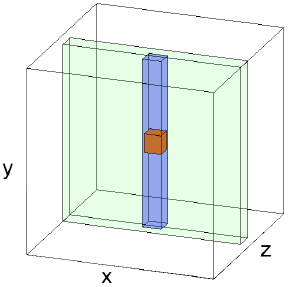
FIG. 1. Illustration of high dimensional slices in 3D space. A slice of the cube can be made along one dimension (e.g., ˜ z ¼ 0 , the green volume), two dimensions ( ˜ z; ˜ x ¼ 0 , blue) or all three dimensions ( ˜ z; ˜ x; ˜ y ¼ 0 , red). If the 1D and 2D slice volumes are projected onto the y , z plane, they will be indistinguishable, as the slice ˜ x is along an unplotted